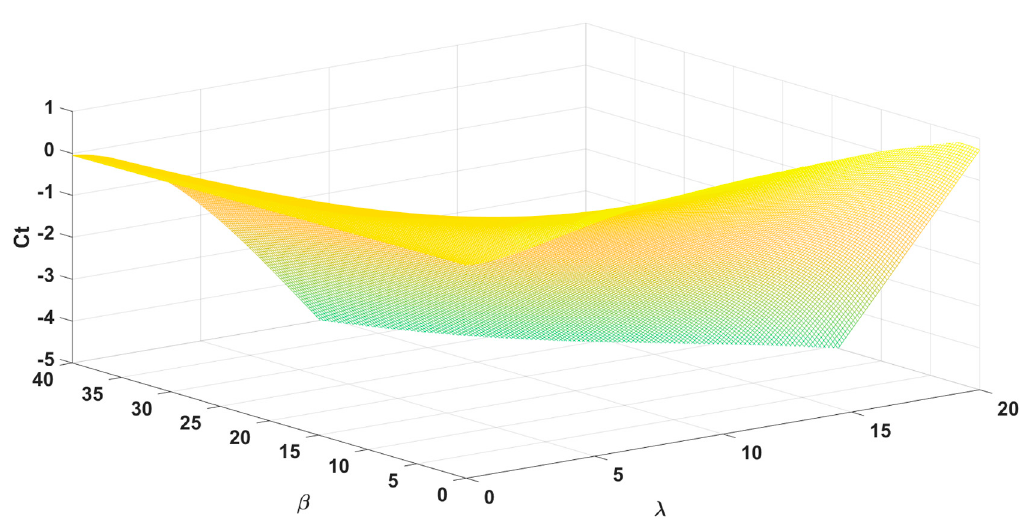
Figure 4. The thrust coefficient for 5-MW VSWT.